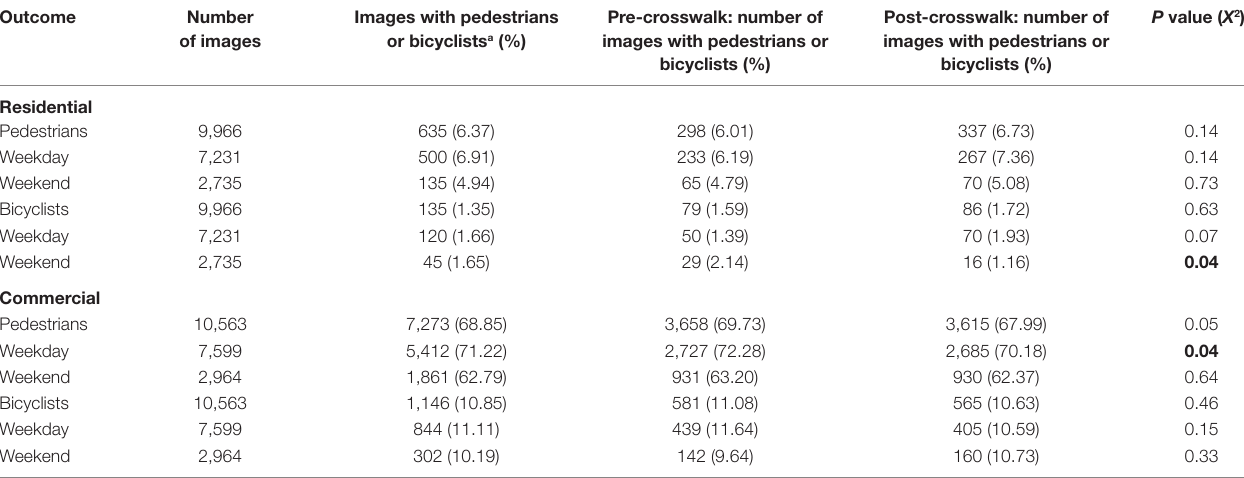
TaBle 1 | number of images with pedestrians and bicyclists before and after crosswalk enhancement. outcome number images with pedestrians Pre-crosswalk: number of Post-crosswalk: number of P value ( X 2 ) of images or bicyclists a (%) images with pedestrians or images with pedestrians or bicyclists (%) bicyclists (%)